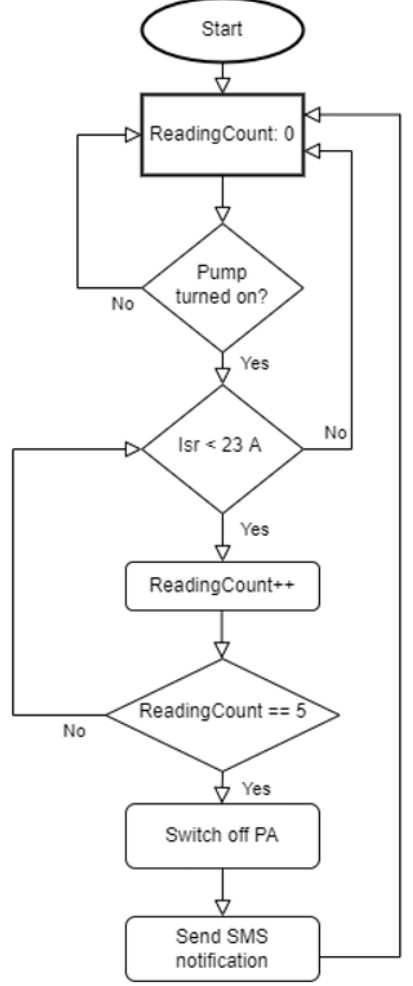
Figure 31. The algorithm for the tolerant control after a pressure switch failure.